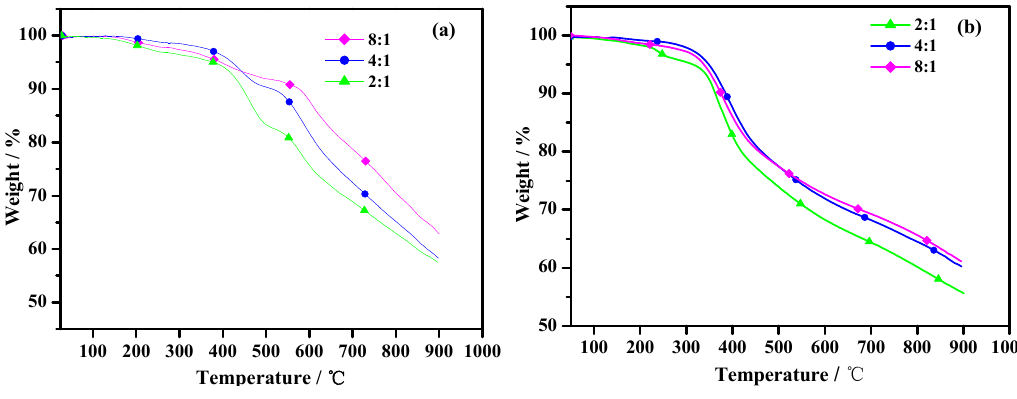
]/[monomer] ratio: 2:1; 4:1; 3